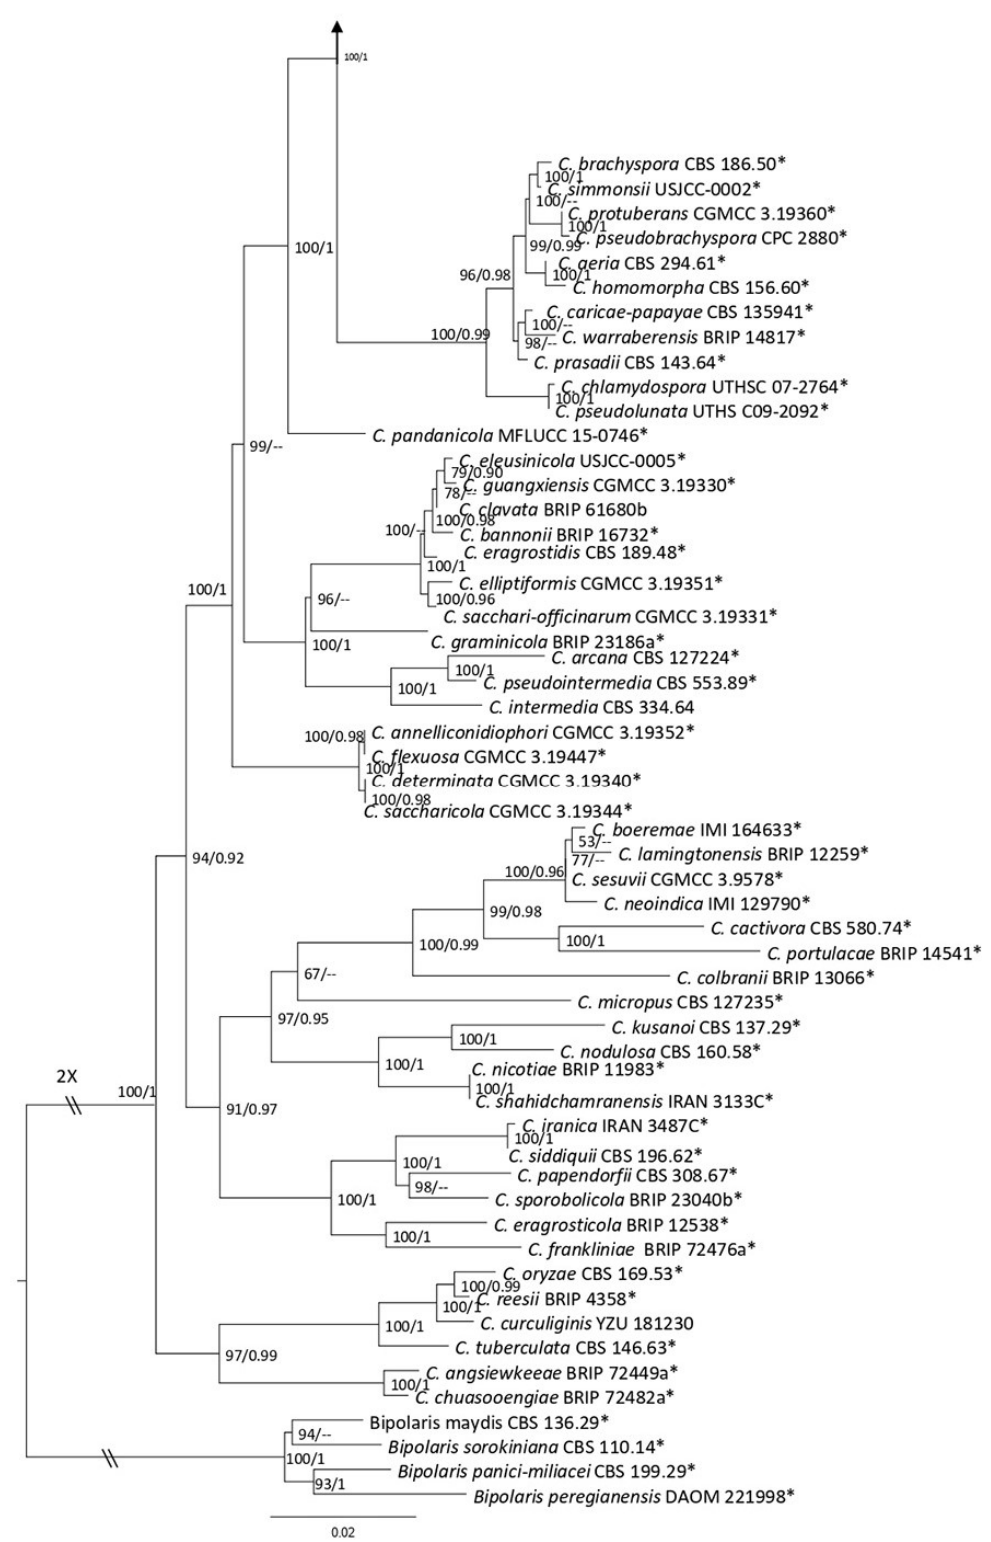
Figure 3. Maximum likelihood (ML) phylogenetic tree of Curvularia spp. Obtained from combined ITS, gapdh , and tef1 sequence data. The ultrafast maximum likelihood bootstrap support (%) ≥ 50 and BYPP ≥ 0.90 are shown at the nodes. The ex-type strains are marked with an asterisk. The tree is rooted in Bipolaris panici-miliacei (CBS 199.29), B. peregianensis (DAOM 221998), B. sorokiniana (CBS 110.14), and B. maydis (CBS 136 . 29 ).